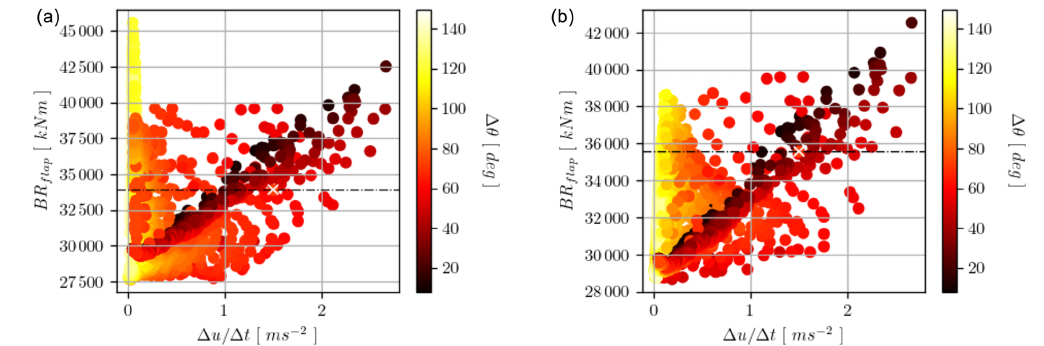
Figure 8. Simulations without yaw control (a) and with yaw control (b) . Blade root flapwise loads as a function of gust acceleration. The colors of the markers refer to the gust directional change in degrees. The IEC ECD case is marked with a white cross, and its value on the y axis is indicated with the dashed horizontal line. Table 3. Absolute maxima of a selection of load channels without yaw control for gusts starting at 10ms − 1 . The IEC absmax column refers to the IEC DLC1.4 gust case with a rise time of 10s, amplitude of 15ms − 1 , and a directional change of 72 ◦ . Ampl. Rise Acc. Dir. Channel Absmax IEC % diff [ ms − 1 ] time [ ms − 2 ] change